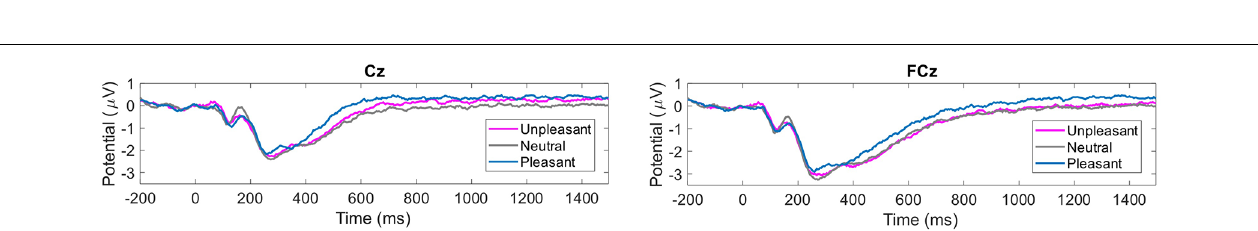
FIGURE 4 | Grand average of the ERPs for each valence condition. Left: Cz. Right: FCz. Time in milliseconds from picture onset is plotted.